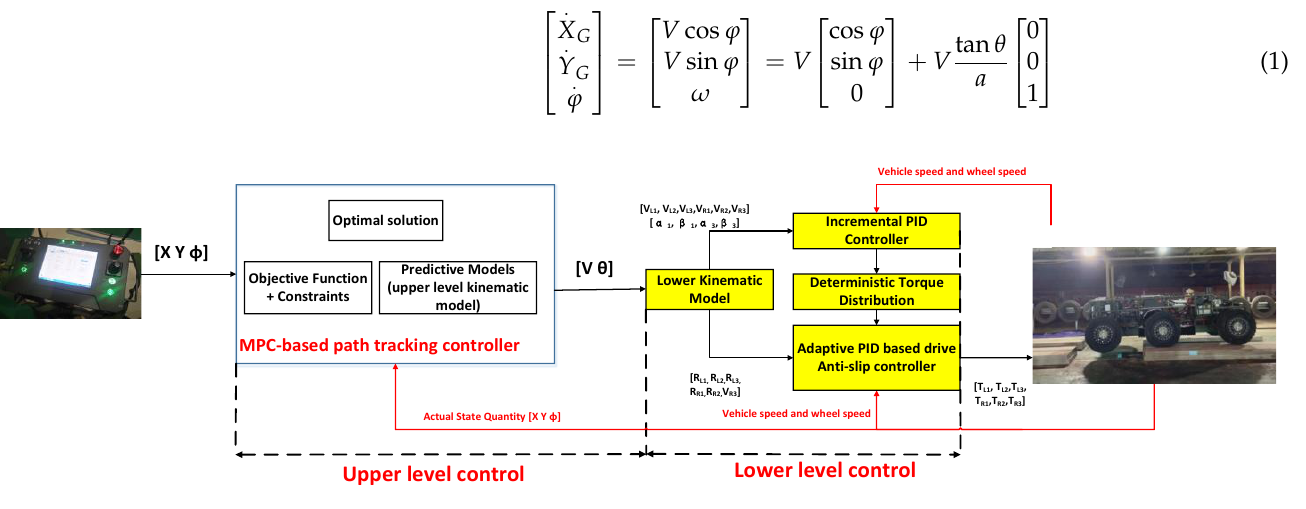
Figure 2. Coordinated control strategy of the distributed unmanned vehicle with a fully electric drive.